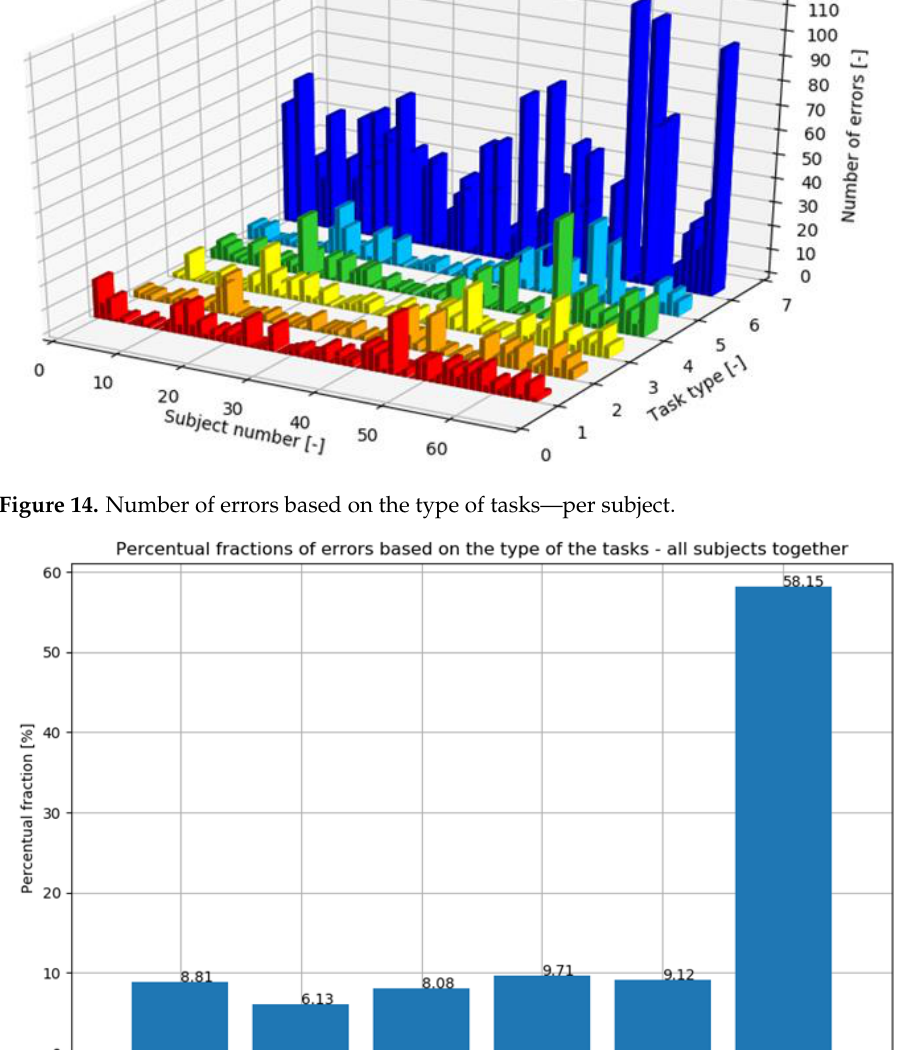
Figure 15. Percentage fraction of errors based on the type of tasks — all subject together.